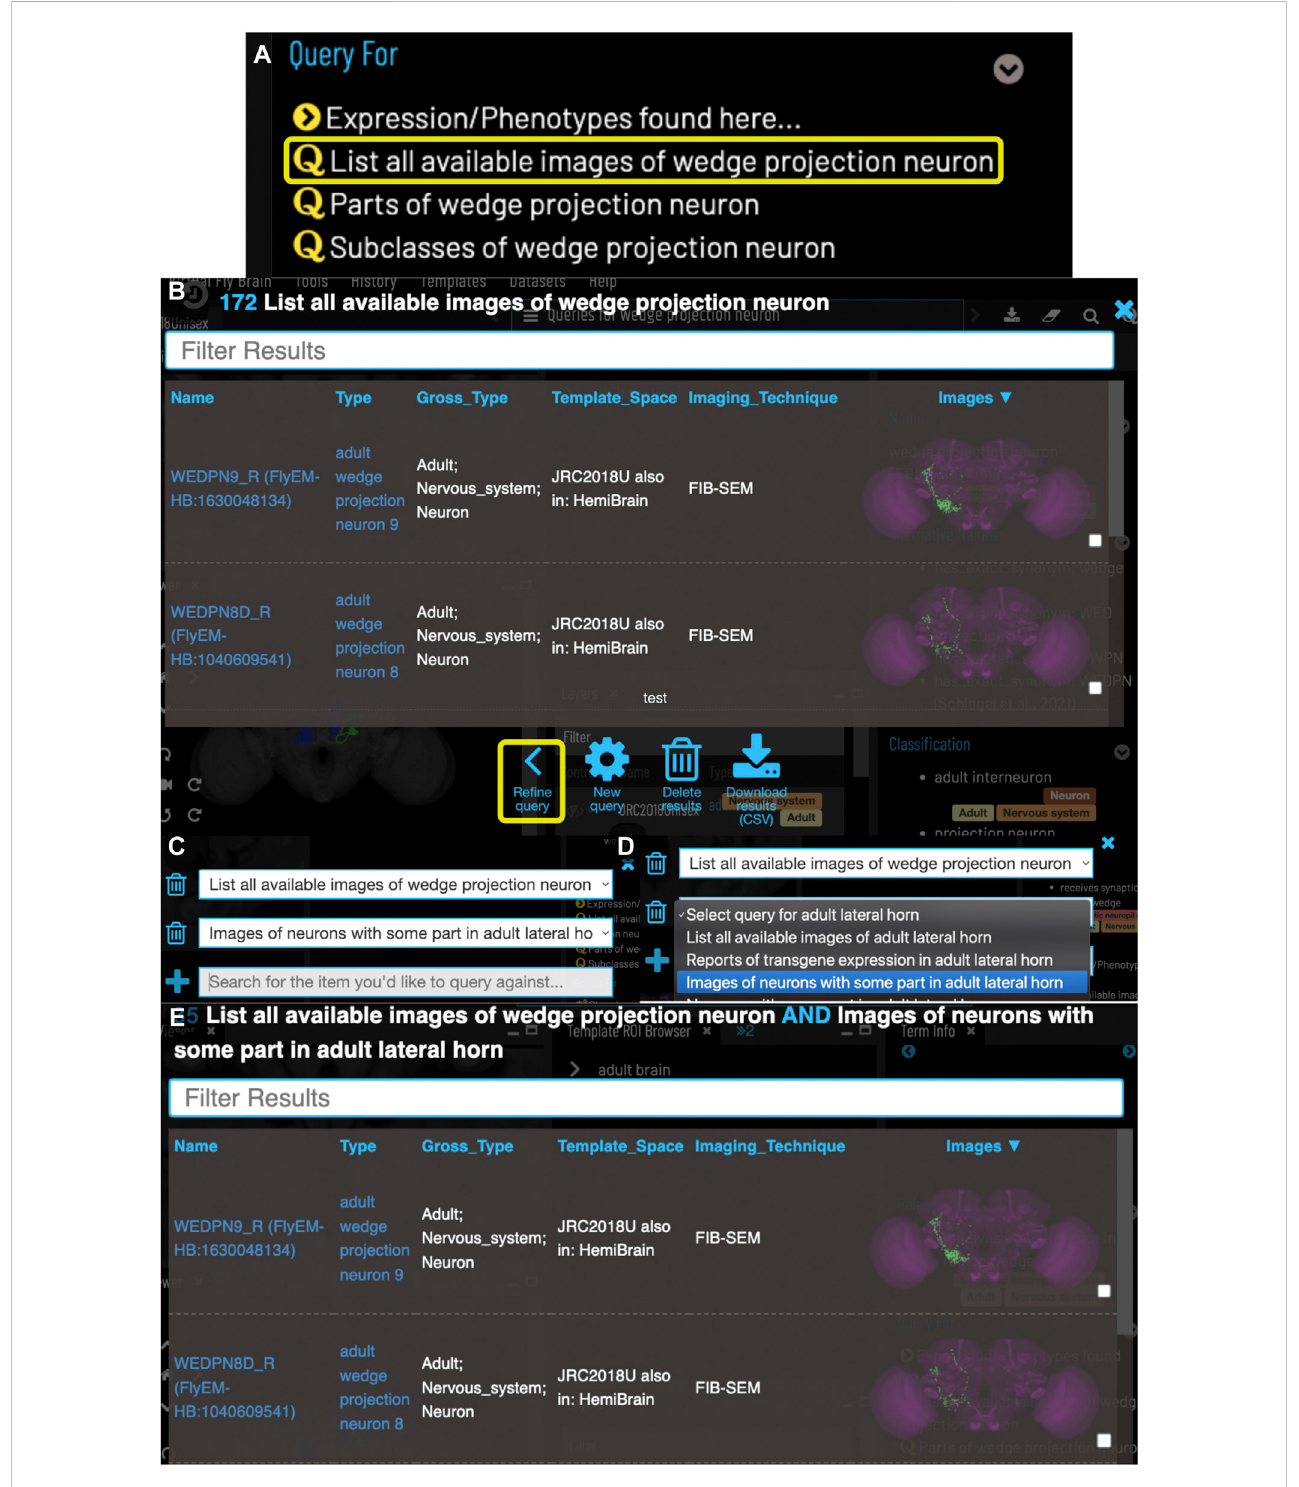
FIGURE 4 Compound Queries. The Term Info pane (A) shows queries available in the TermInfo of “ wedge projection neuron ” . Clicking on the query for available imagesof “ wedgeprojectionneuron ” bringuparesultstable (B) whichcanbefurtherre fi nedbyclicking “ Re fi neQuery ” underneath.Thequeryinterface (C,D) showstheoriginalqueryandallowsasecondquerytoberunto fi nditemsthat fi tbothsetsofcriteria,inthiscaseimagesofneuronsthatalsohavesomepartin the lateral horn. Images in the subsequent results table (E) can be added to the viewer by clicking the checkboxes on the